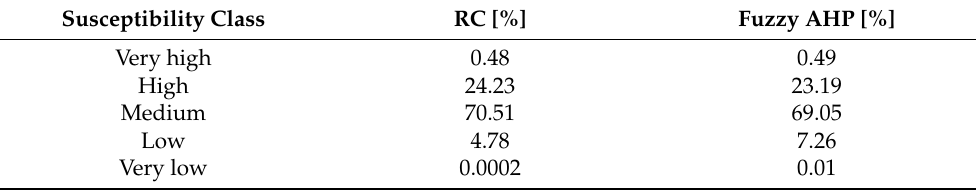
Table 8. Share of forest fire susceptibility zones in total nature park